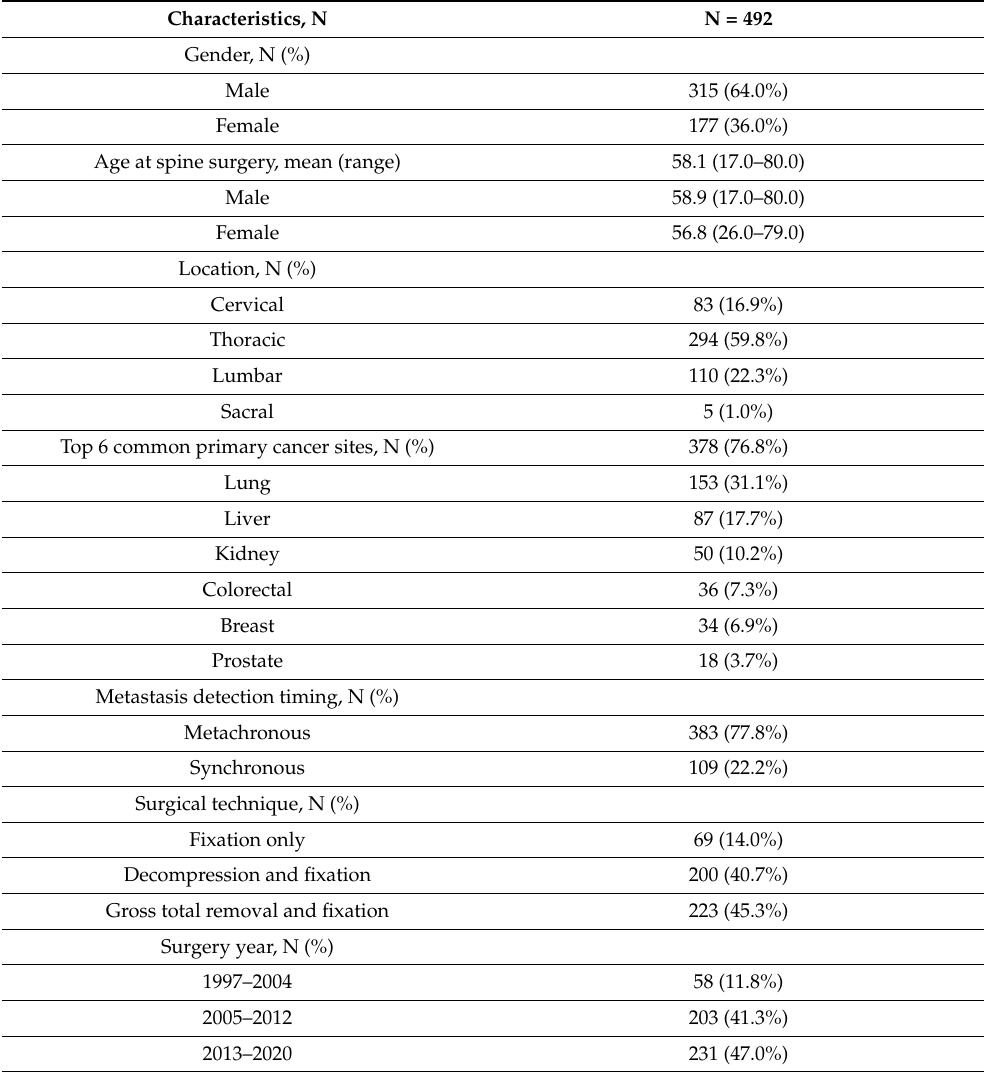
Table 1. Baseline